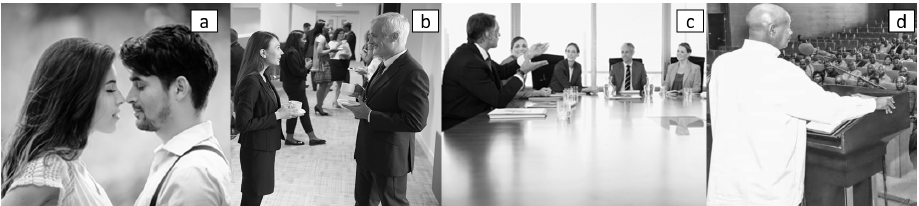
Figure 1. Interpersonal distances of people according Edward Hall’s proxemic theory (showing radius in meters) [24].